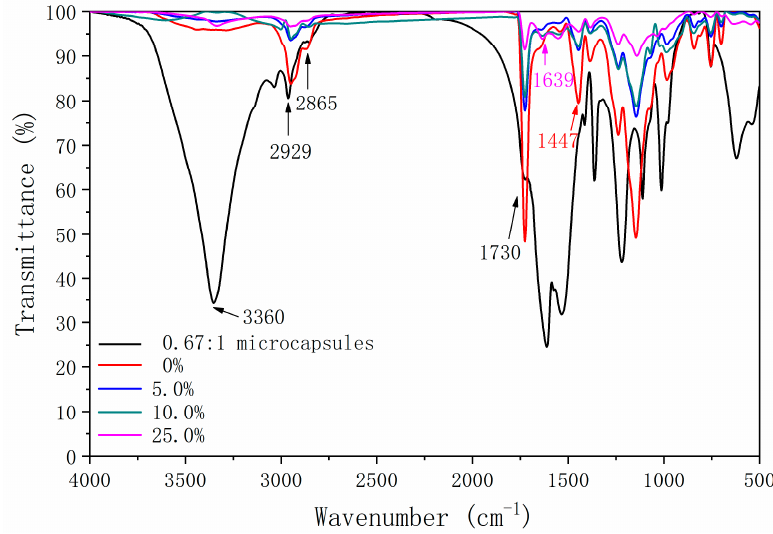
Figure 6. Infrared spectrogram of 0.67:1 microcapsule and water-based topcoat paint film.